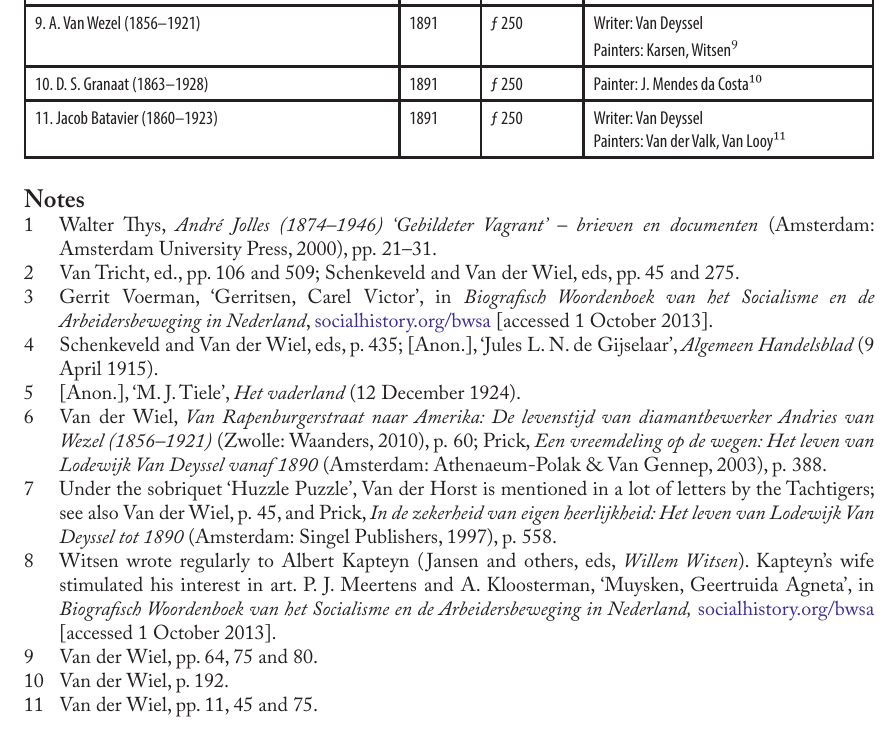
Table 2 Financial backers of De nieuwe